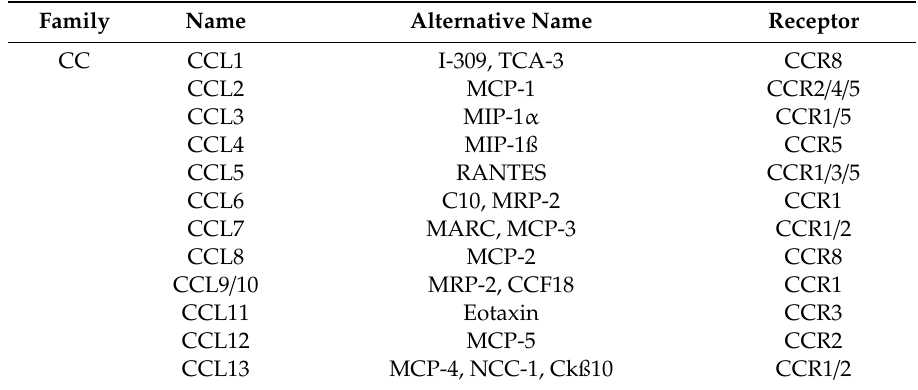
Table 1. Chemokine families, their members, alternative names and interacting receptors are